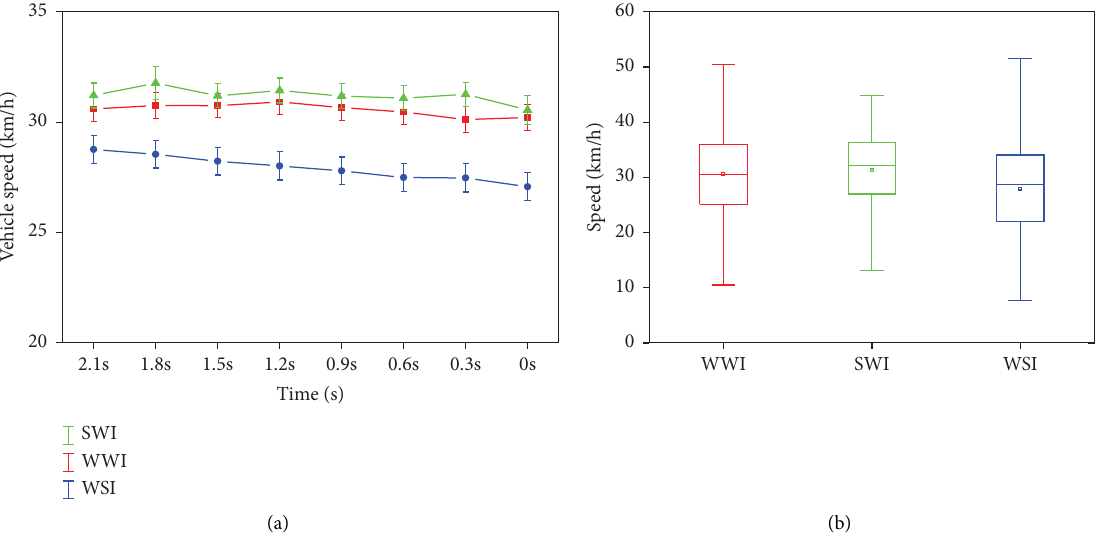
Figure 9: Vehicle speed under diferent crossing intentions. (a) Line chart of vehicle speed change with time under diferent intentions. (b) Box diagram of vehicle speed under diferent crossing